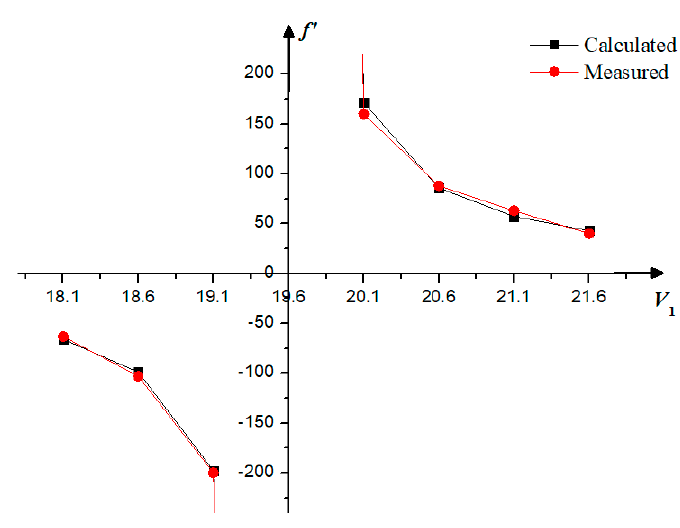
Figure 11. The focal length of the UTL comparison among calculated and measured values.